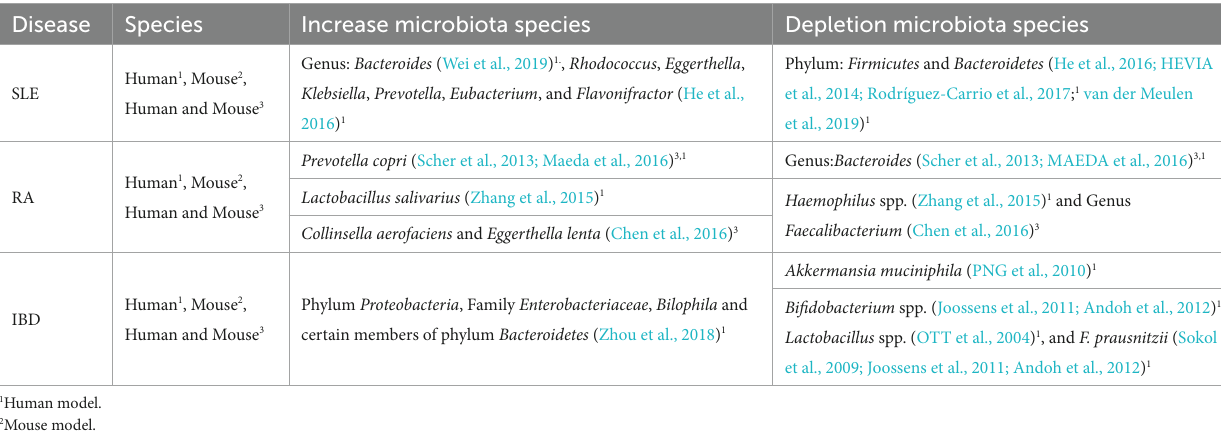
TABLE 1 Autoimmune diseases and alteration of the gut microbiota composition.